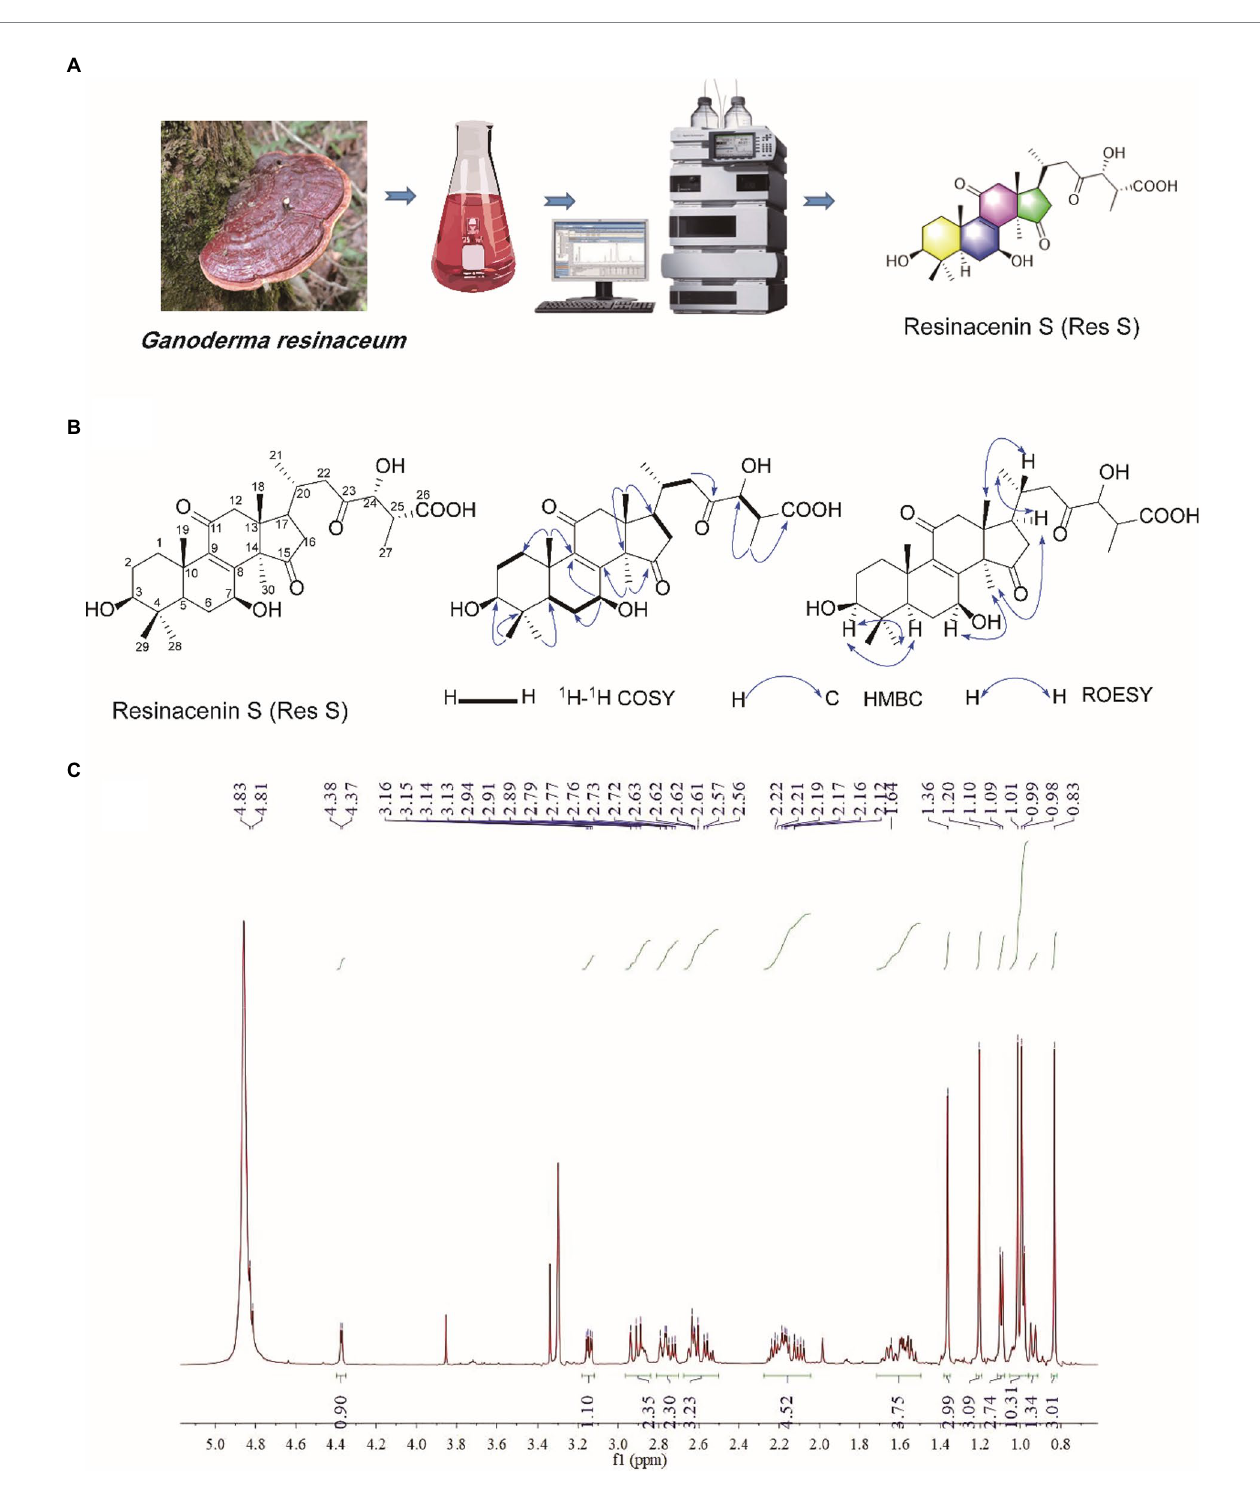
FIGURE 1 Resinacein S was obtained from Ganoderma resinaceum (A) , and 1 H– 1 H COSY correlations, key HMBC, ROESY correlations for Resinacein S (B) , and 1 H NMR spectrum (600 MHz) of Resinacein S in CD 3 OD (C)